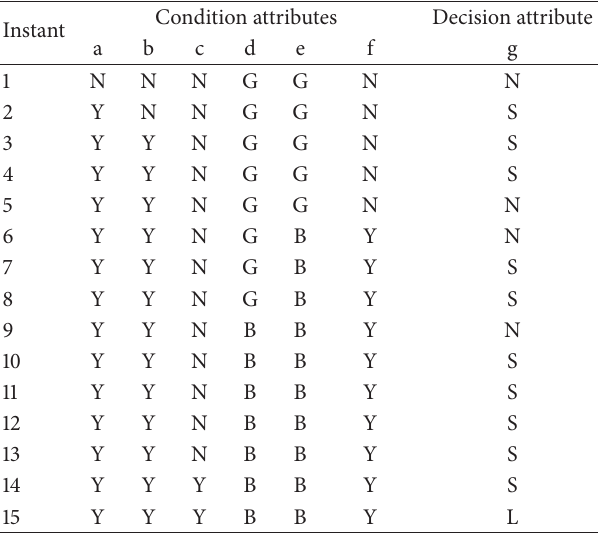
Table 1: Road traffic accident table.